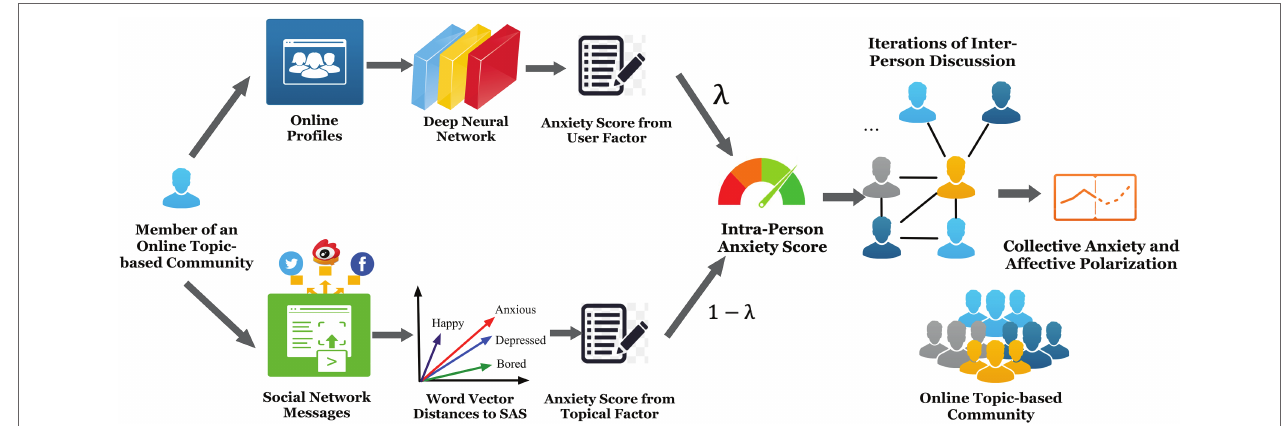
FIGURE 1 | Framework of the computational model for collective anxiety